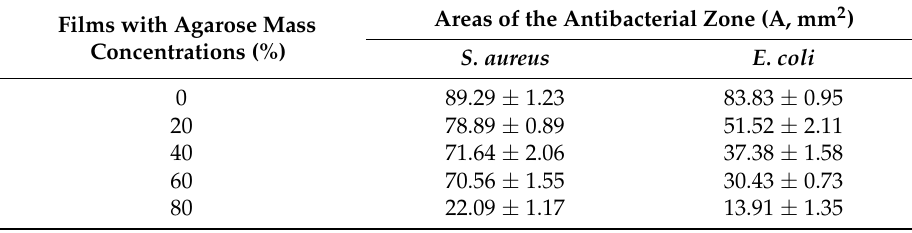
Table 1. The antibacterial effects of the composite films with different agarose contents against S. aureus and E. coli